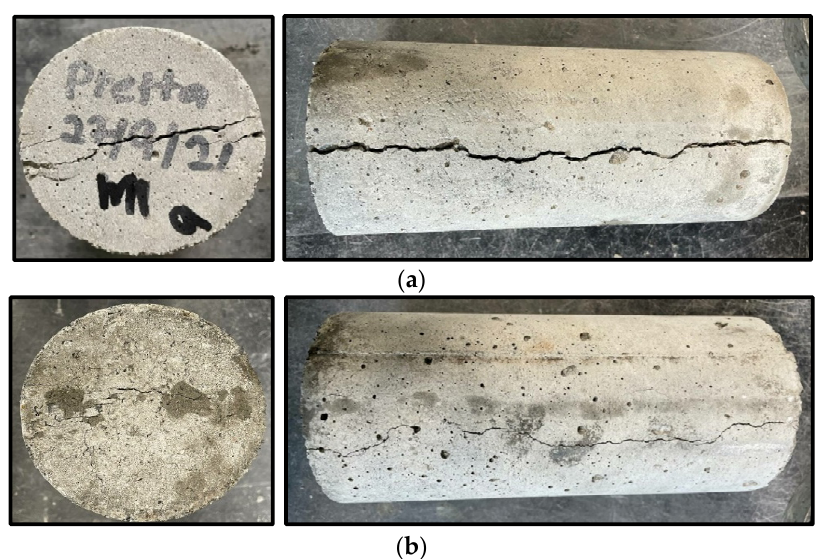
Figure 9. NaOH-CRC samples after splitting tensile test. ( a ) M1 (0%NaOH, 0%CR). ( b ) M2 (10%NaOH, 5%CR).